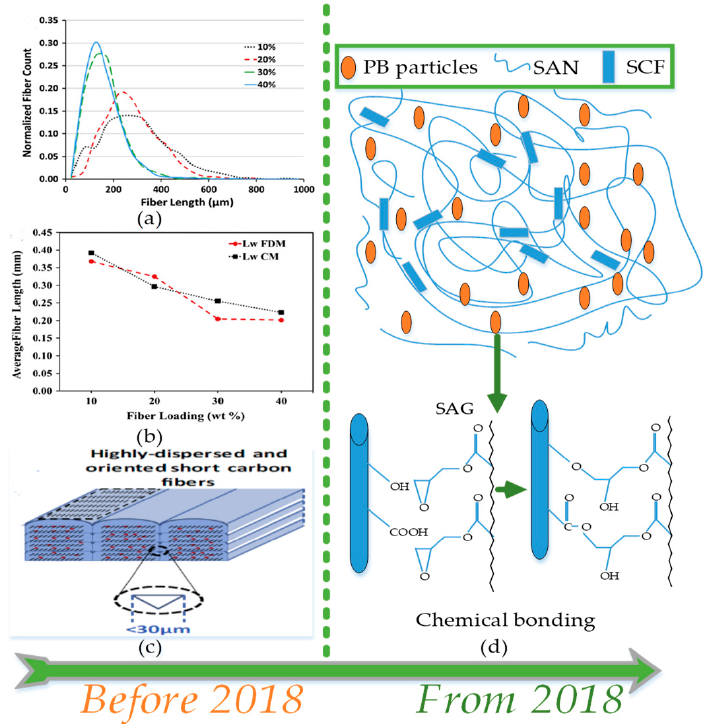
Figure 14. Development in research of discontinuous fiber reinforced FFF polymers before and from 2018: ( a ) fiber length distributions in FFF printed specimen; ( b ) weight average fiber lengths of FFF samples, and ( c ) dispersion of fibers in specific orientation. Adapted from [188], with permission from © 2014, Elsevier. ( d ) Illustration of chemical reaction of styrene acrylonitrile glycidyl methacrylate (SAG) on surface of short carbon fibers, adapted from [162], with permission from © Taylor & Francis .